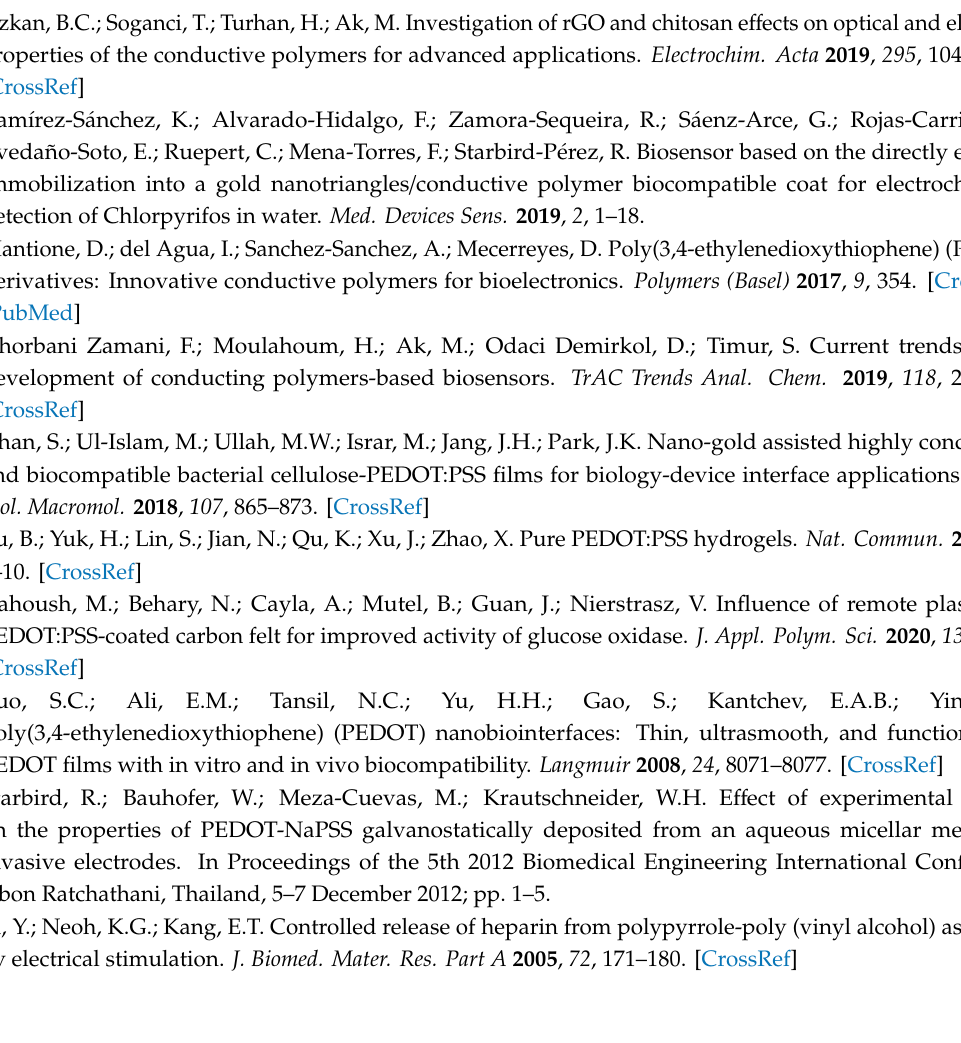
Supplementary Materials: The following is available online, Figure S1: Galvanostatic curve of the electro-polymerization process from an EDOT: κ C:Dx dispersion onto a bare gold electrode. Figure S2. Raman spectra of the PEDOT: κ C:Dx coating (a.) before dexamethasone release process (Inset: PEDOT: κ C:Dx electrode surface) and (b.) after 160 release cycles (Inset: PEDOT: κ C:Dx electrode surface). Figure S3. µ -Raman spectral measurement of the dexamethasone 21-phosphate disodium salt. Figure S4. Deposited PEDOT: κ C:Dx electrode after 160 cycles of electrical stimulation (left) and gold electrode without passivation as reference (right). Table S1: Gradient elution method for the mobile phase using during dexamethasone analysis. Solvents were water: 0.05% formic acid (A) and methanol: 0.05% formic acid (B). and S1: Configuration of the mass spectrometer during dexamethasone